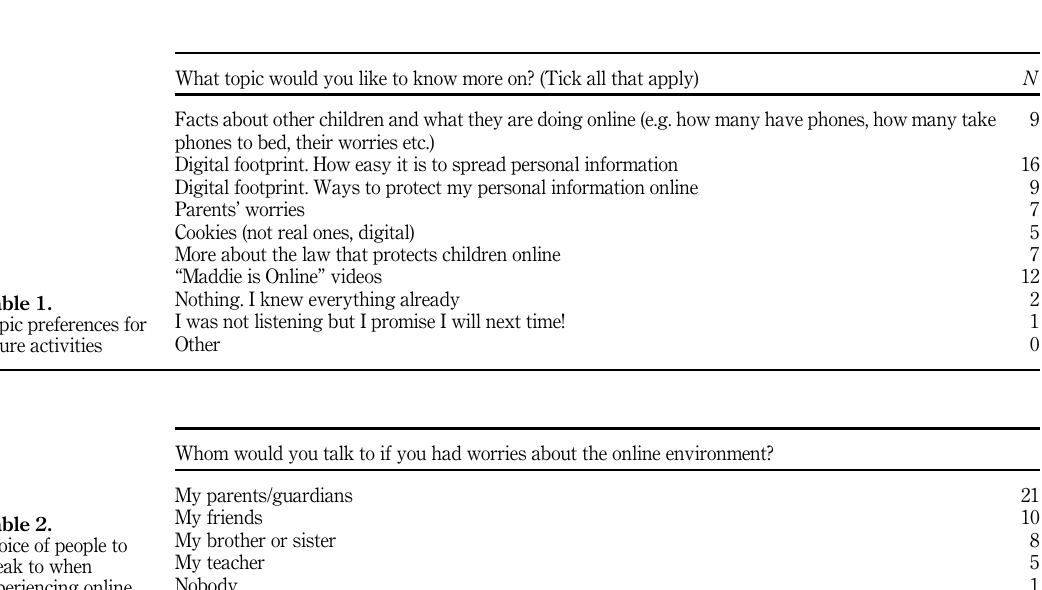
Table 2. Choice of people to speak to when experiencing online